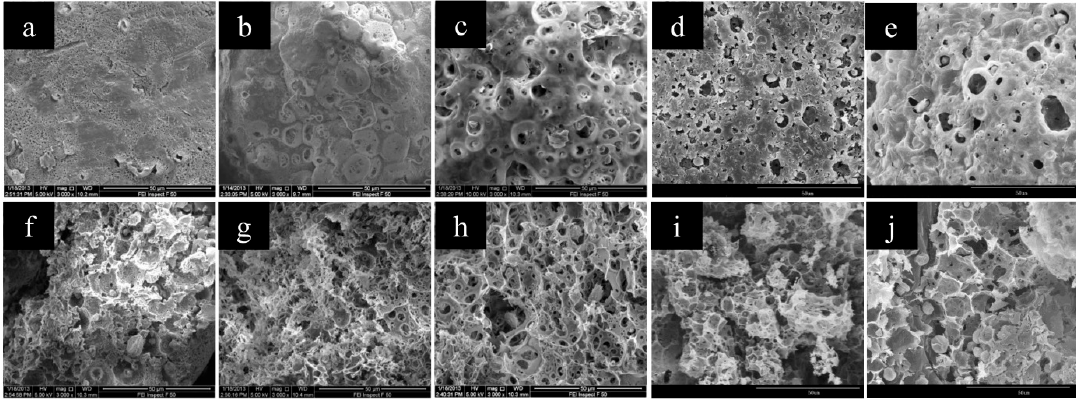
Figure 7. The SEM images of CMC/CA microspheres fabricated with W1/O ratios of 10/100 ( a , f ), 30/100 ( b , g ), 50/100 ( c , h ), 70/100 ( d , i ), and 90/100 ( e , j ). Images ( a – e ) were the surface images while ( f – j ) were the cross-section images of the CMC/CA microspheres.